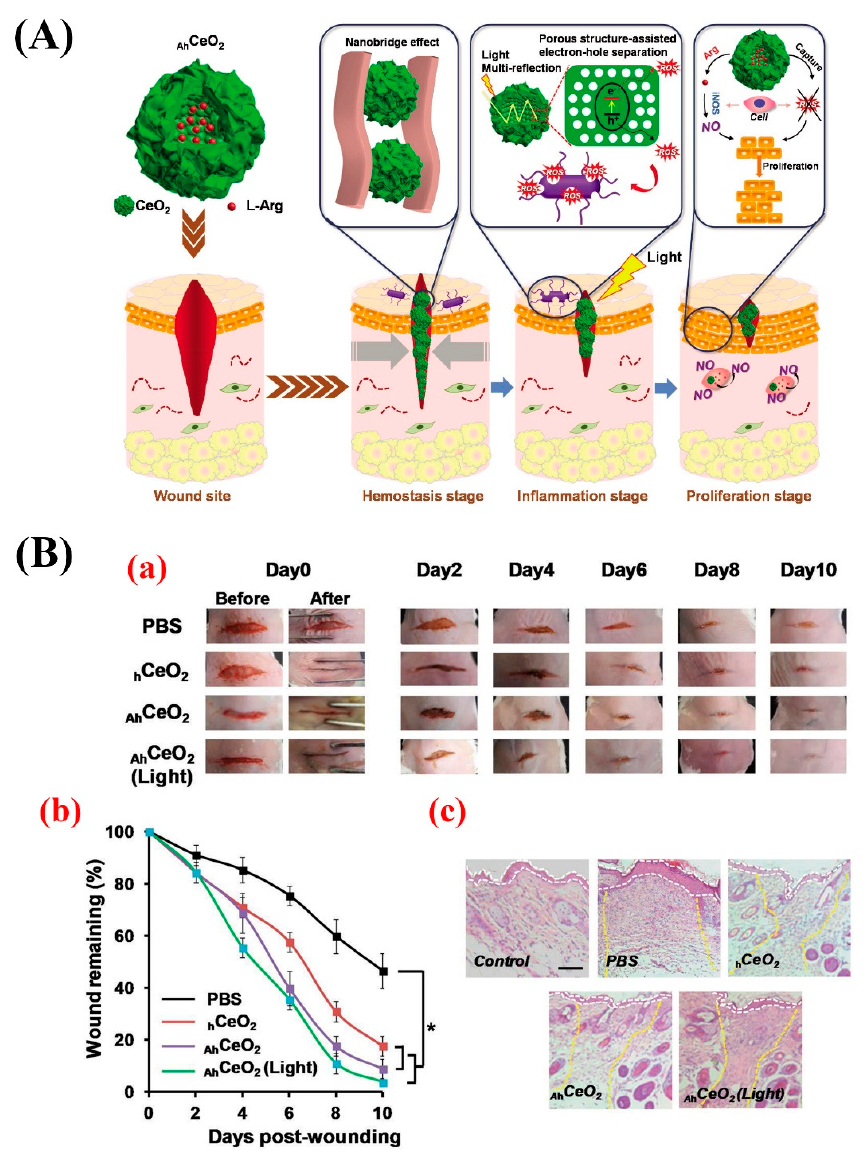
Figure 4. ( A ) Schematic representation of the hierarchical promotion of multiple wound-healing stages by applying a rough surface on L-arginine (L-Arg) inside CNPs ( Ah CeO 2 NPs). At the hemostasis stage, the modified nanoparticles can serve as a tissue nanobridge to rapidly close the wound and inhibit the bleeding. At the inflammatory stage, Ah CeO 2 NPs show excellent light-harvest efficiency based on light multi-reflection properties inside hollow structures, as well as high electron-hole separation efficiency thanks to their porous shell, which can efficiently produce reactive oxygen species (ROS) to kill bacteria under simulated sunlight irradiation. At the proliferation stage, the particles can capture the excess ROS generated at the wound site due to their superoxide dismutase (SOD) and catalase (CAT) activities, and the released L-Arg can be converted into nitric oxide (NO) by inducible nitric oxide synthase (iNOS) overexpressed in macrophages and, subsequently, promoting cell proliferation. ( B ) Micrographs showing the wound healing within 10 days post-treatment, (a) the quantification of wound-healing kinetics expressed as a percentage of the initial wound length, (b) and hematoxylin and eosin (H&E)-stained tissue samples at 10 days post-treatment (c) (the white dashed lines indicate the boundary of the epidermal layer, and the yellow dashed lines show that the boundary of the wound area remains fully regenerated). Scale bar: 100 µ m. Reproduce from